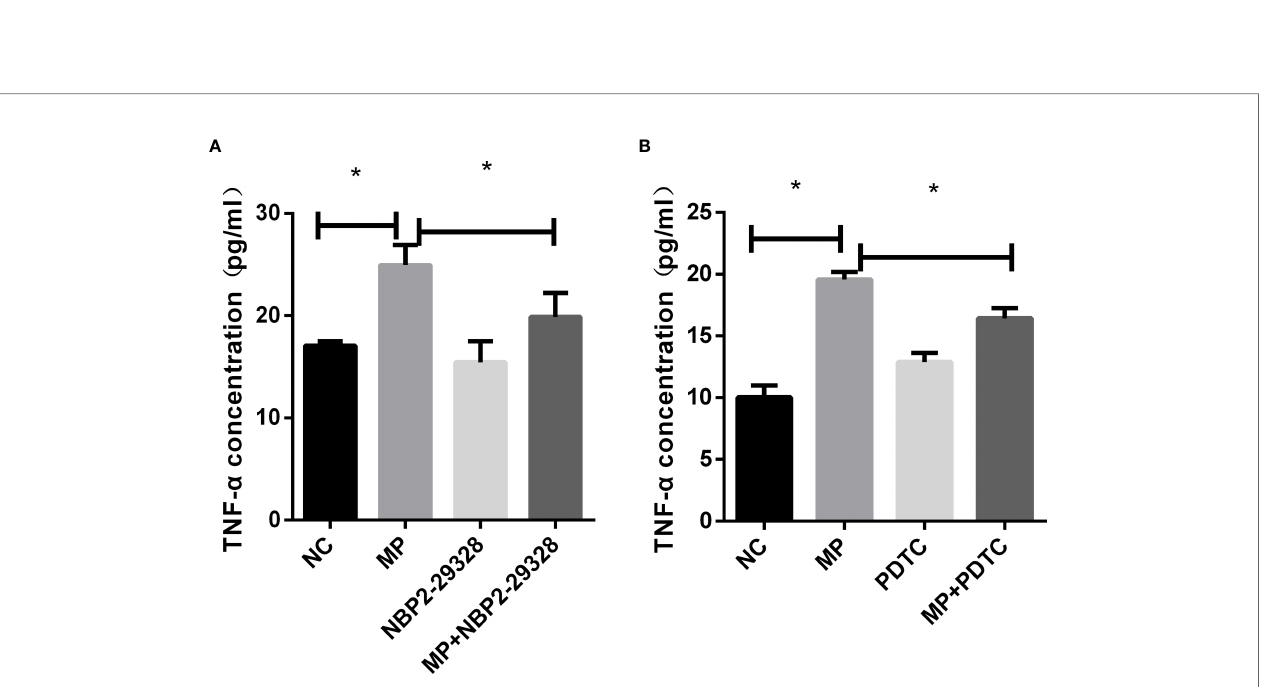
FIGURE 5 | TNF- a secretion measured by ELISA in control or MP-infected A549 cells incubated with (A) MyD88 or (B) NF- k B inhibitors. *P < 0.05 is statistically signi fi cant. NC, normal control; MP, Mycoplasma pneumoniae ; PDTC, Pyrrolidinedithiocarbamic acid, a NF- k B inhibitor; NBP2-29328, a MyD88 Inhibitor